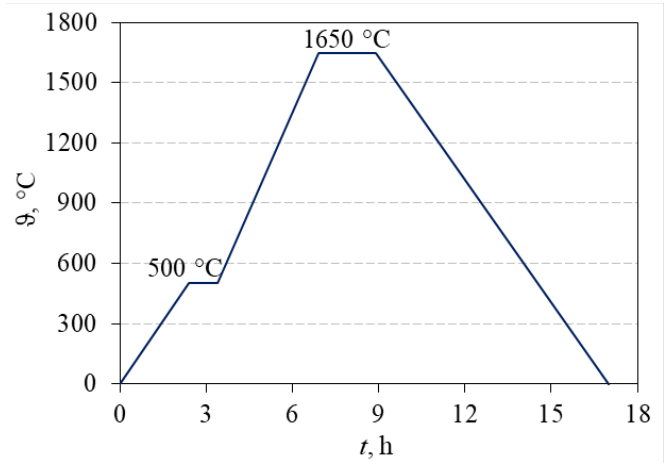
Figure 3. Schema of sintering regime of monolithic Al 2 O 3 and Al 2 O 3 –ZrO 2 composite ceramics.